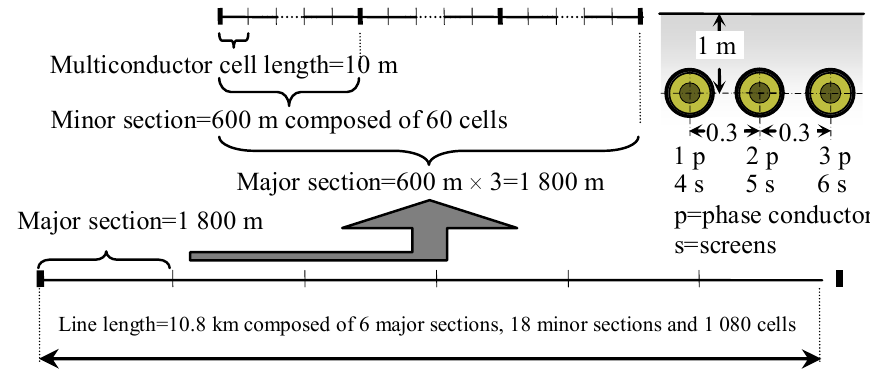
Figure 2. Subdivision of the single-circuit cable line in cross-bonding with indication of cells and minor and major sections (not to